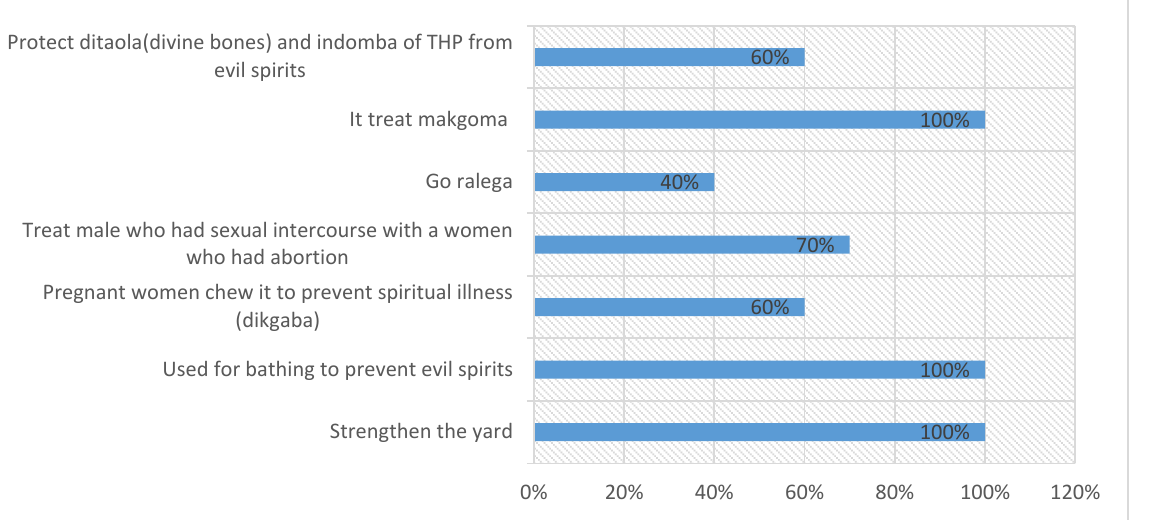
Figure 3. Distribution (%) of the spiritual and cultural uses of African ginger in the study area. THP= traditional health practitioners. Makgoma : diverse cultural/spiritual illness/conditions and repercussion from the violation of taboos; Go ralega : protection of children from spiritual attacks that may be contact from individuals that had abortion or miscarriage that is kept as a